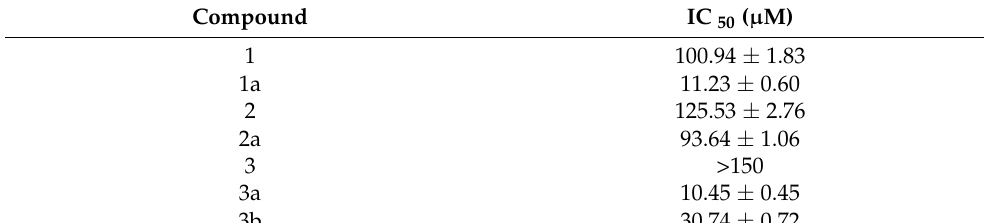
Table 5. Antiproliferative activities (IC 50 ) of the compound against MCF-7 human breast cancer cells (mean ± SD, n = 3).